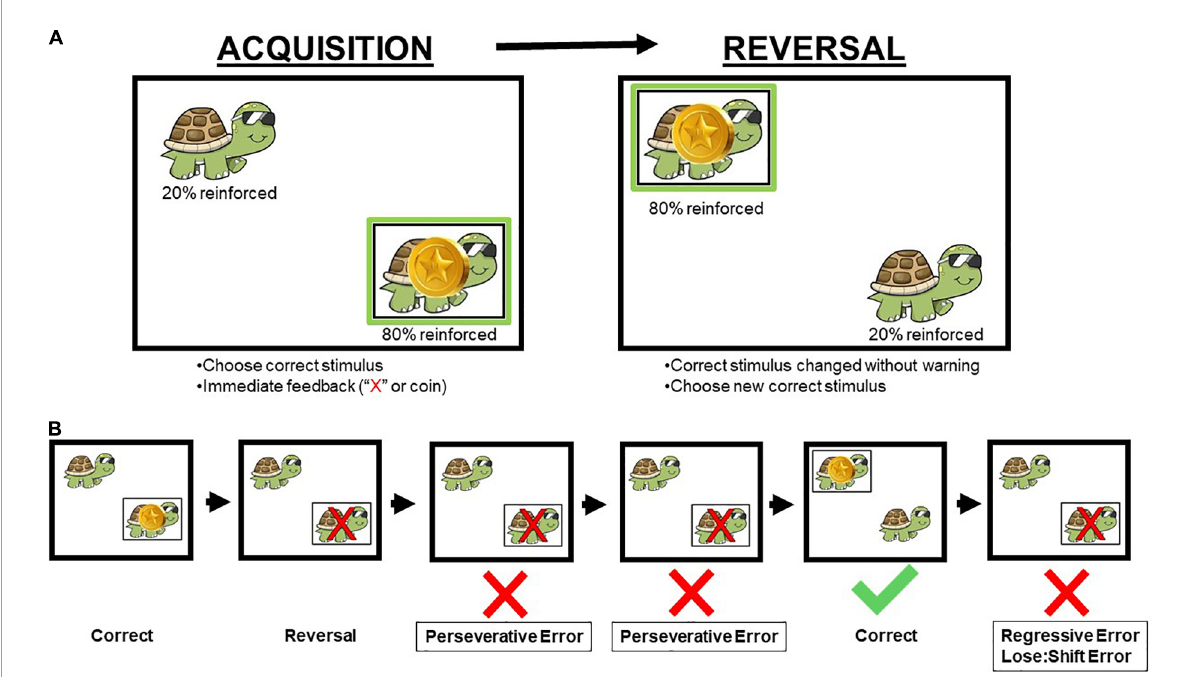
FIGURE1 Schematic of the human probabilistic reversal learning task (A) and error types (B) . Participants were instructed to select the animal in the correct stimulus location on the screen (Acquisition). Once participants reached performance criterion, the correct stimulus location changed without warning to the other location on the screen (Reversal). Across both acquisition and reversal phases, reinforcement was provided on an 80:20 probabilistic schedule, and correct responses were reinforced with coins. A red “X” appeared over the animal if the incorrect stimulus location was chosen by the participant. Perseverative errors occurred when a participant chose the previously reinforced location prior to choosing the newly reinforced (correct) location. Regressive errors occurred when a participant chose the previously reinforced location after choosing the newly reinforced location. Lose:shift errors are a specific type of regressive error when participants chose the previously reinforced location immediately following inaccurate feedback (e.g., 20% of trials) that their choice was incorrect. Animal and location on the screen were randomized for each participant with a total of four possible combinations of animal and location. Permission to use image from author (Schmitt et al.,